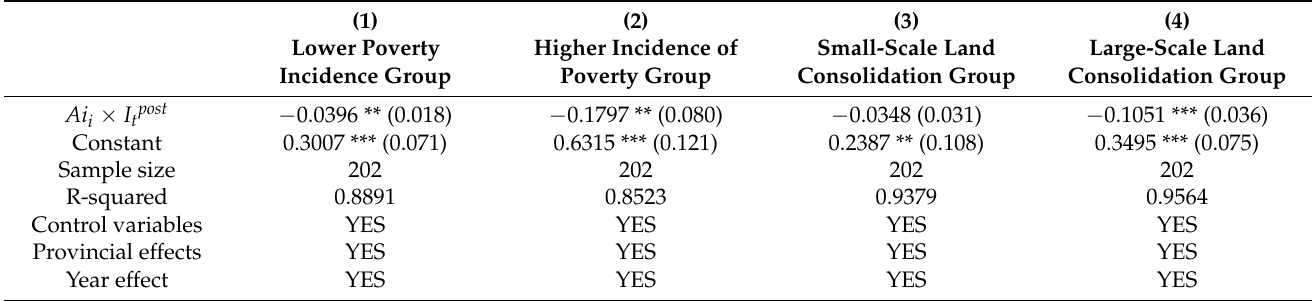
Table 5. Results at different poverty levels and land consolidation